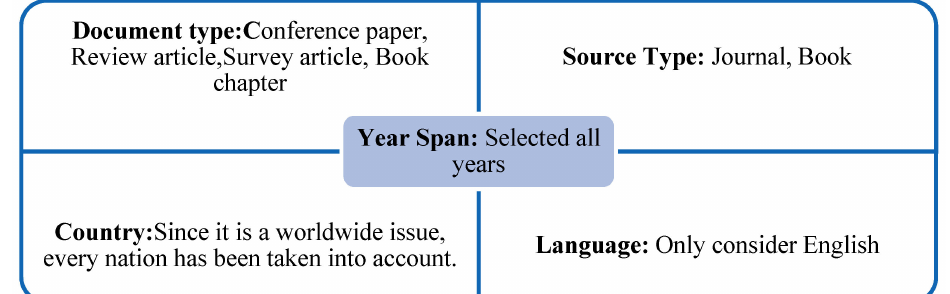
Figure 11. Basic Principles of Data